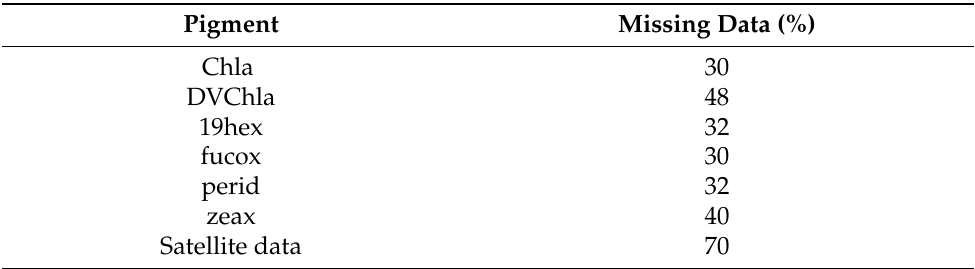
Table 1. Missing data for each pigment (among the 9 depths) and for the satellite variable of the experimental dataset D